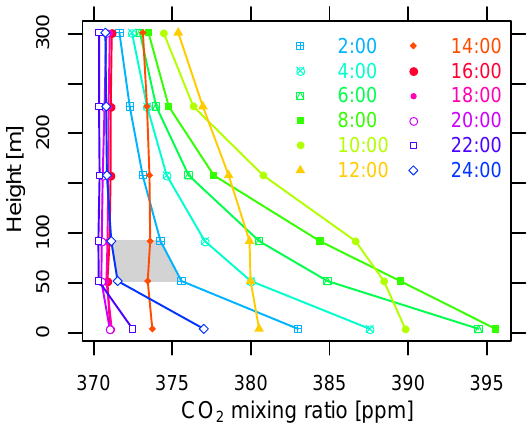
Fig. 1. Average diurnal development of the CO 2 profile along the tall tower during July 2009; the grey-shaded area illustrates stor- age flux component between 52 and 92m and between 00:00 and